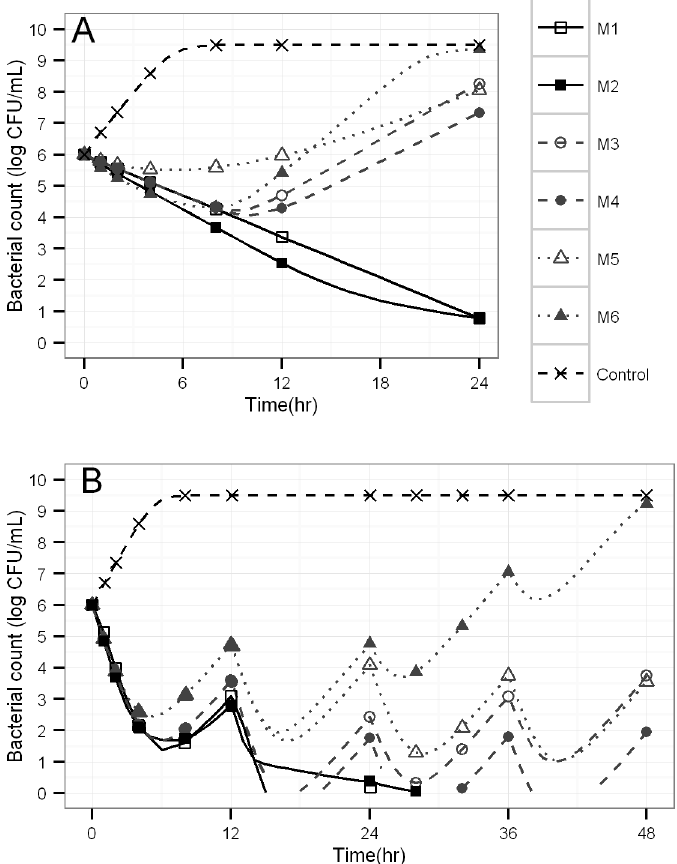
Fig 3. Typical viable count profiles. Simulations via six different structural models for a constant antibiotic concentration of 1 mg/L (panel A) or for multiple dosing of a hypothetical antibiotic with 1 h elimination half-life and peak concentrations of 8 times KC 50S (panel B).